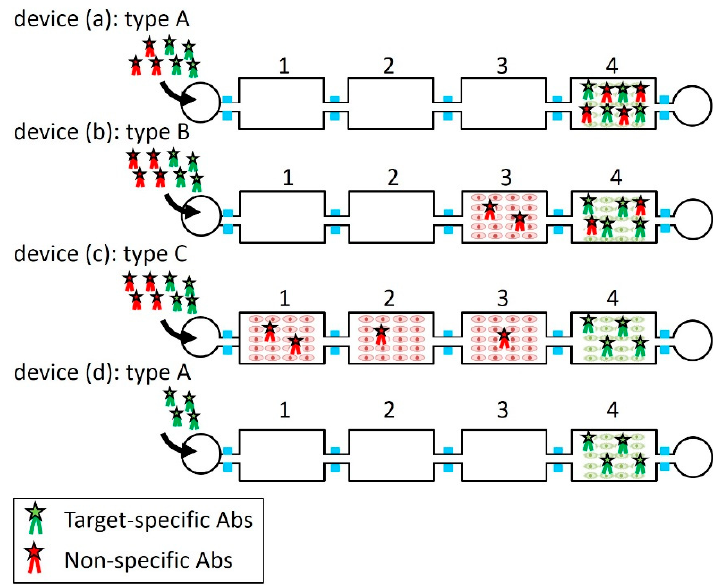
Figure 7. Four microfluidic devices with three types for the experiment of filtering the non-specific antibodies (Abs). The mixture of the fluorescent dye-labeled target-specific Ab and non-specific Ab solutions was introduced to the devices. ( a ) Type A: Three blank and one target cell chambers. ( b ) Type B: Two blank, one non-target cell and one target cell chambers. ( c ) Type C: Three non-target and one target cell chambers. ( d ) Type A: Only target-specific Ab solution was introduced for autofluorescence measurement.